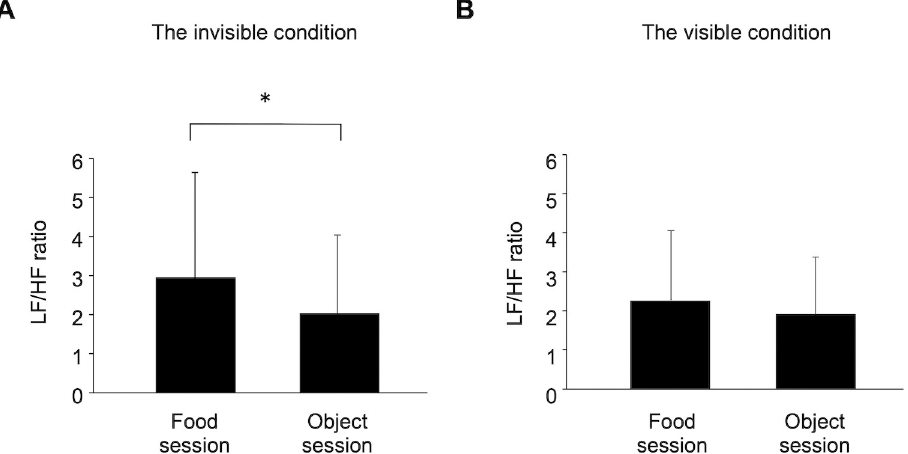
Fig 2. Index of sympathetic nervous activity over each session. (A) The LF/HF ratio assessed by frequency domain analysis of the R-R wave intervals in electrocardiograms (ECGs) under the invisible condition. The LF/HF ratio in the food session was higher than that in the object session. (B) The LF/HF ratio under the visible condition. � P < 0.05 (paired t -test). LF, low-frequency power; HF, high-frequency power.